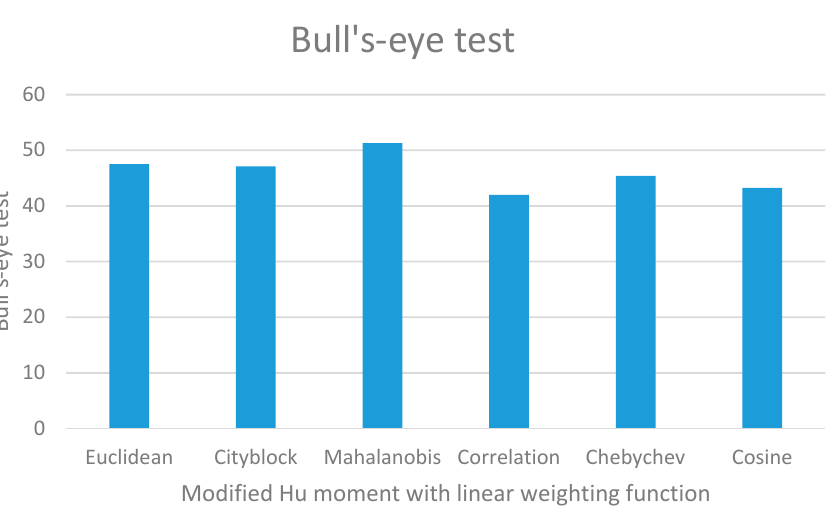
Figure 10. Bull’s-eye test on MPEG-7 shape database.